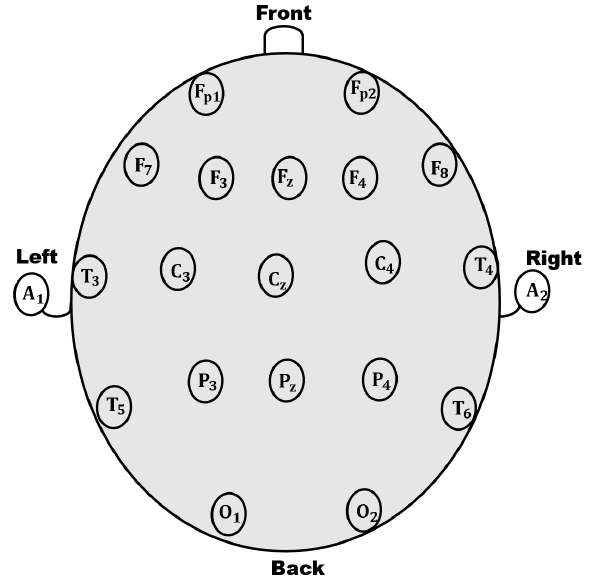
Figure 5. The EEG system with 10–20 international electrode placement.